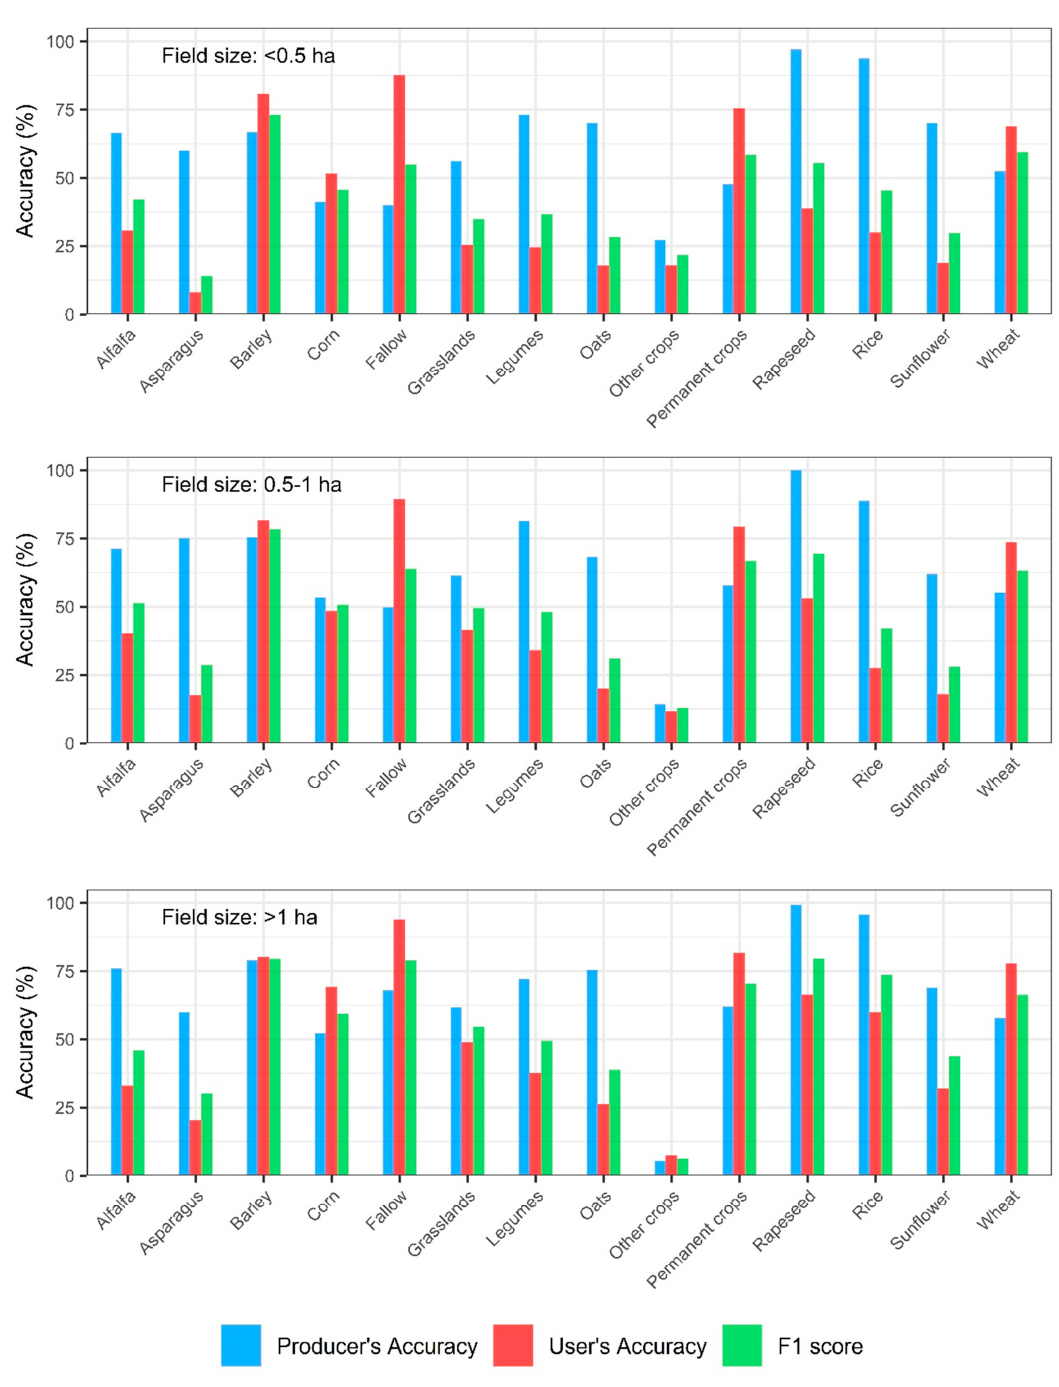
Figure 11. F1-score, Producer’s Accuracy (PA) and User’s Accuracy (UA) of Ens scheme (using R 2 as the best fit metric) based on field size for external validation in Navarre.